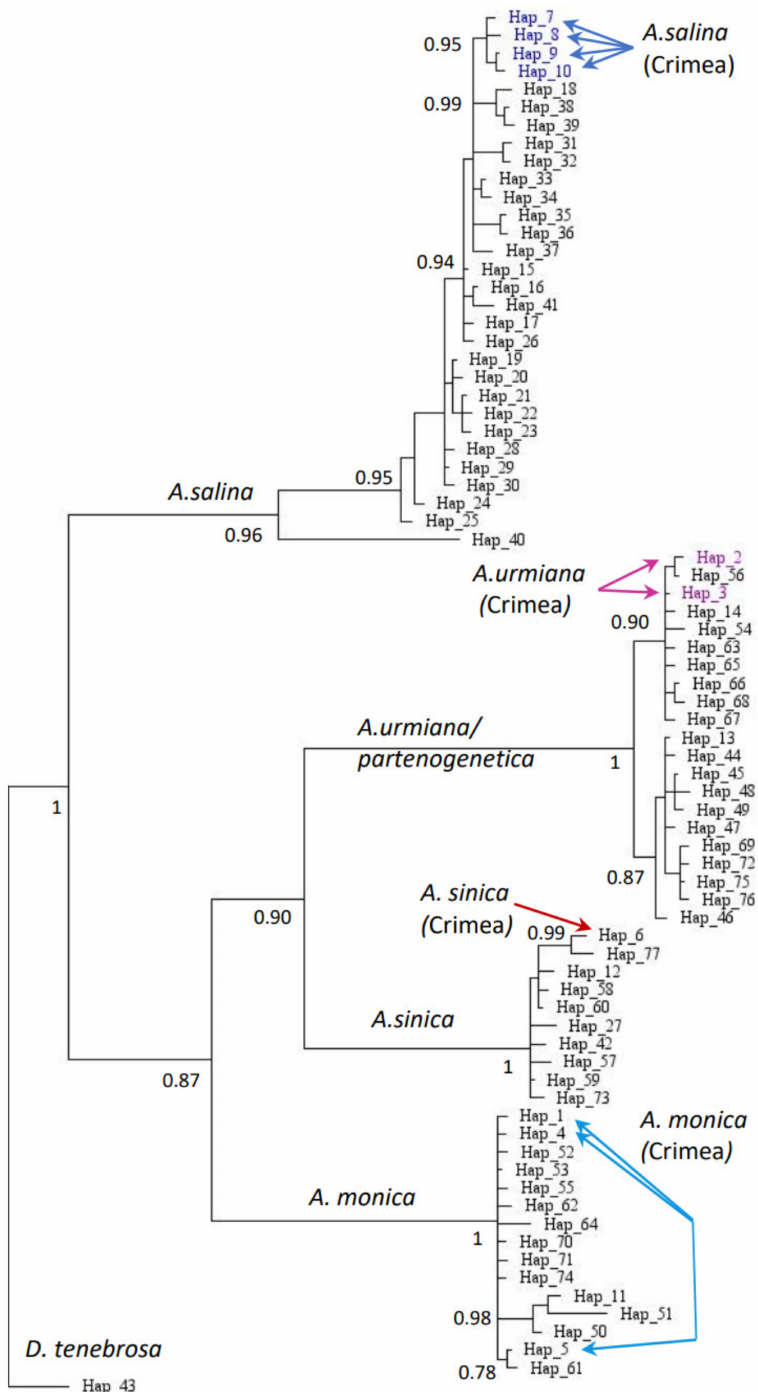
Figure 2. Phylogenetic relationship of analyzed Artemia revealed by Bayesian analysis based on cytochrome c oxidase subunit I (COI). The bootstrap values at the nodes higher than 75% are shown next to the